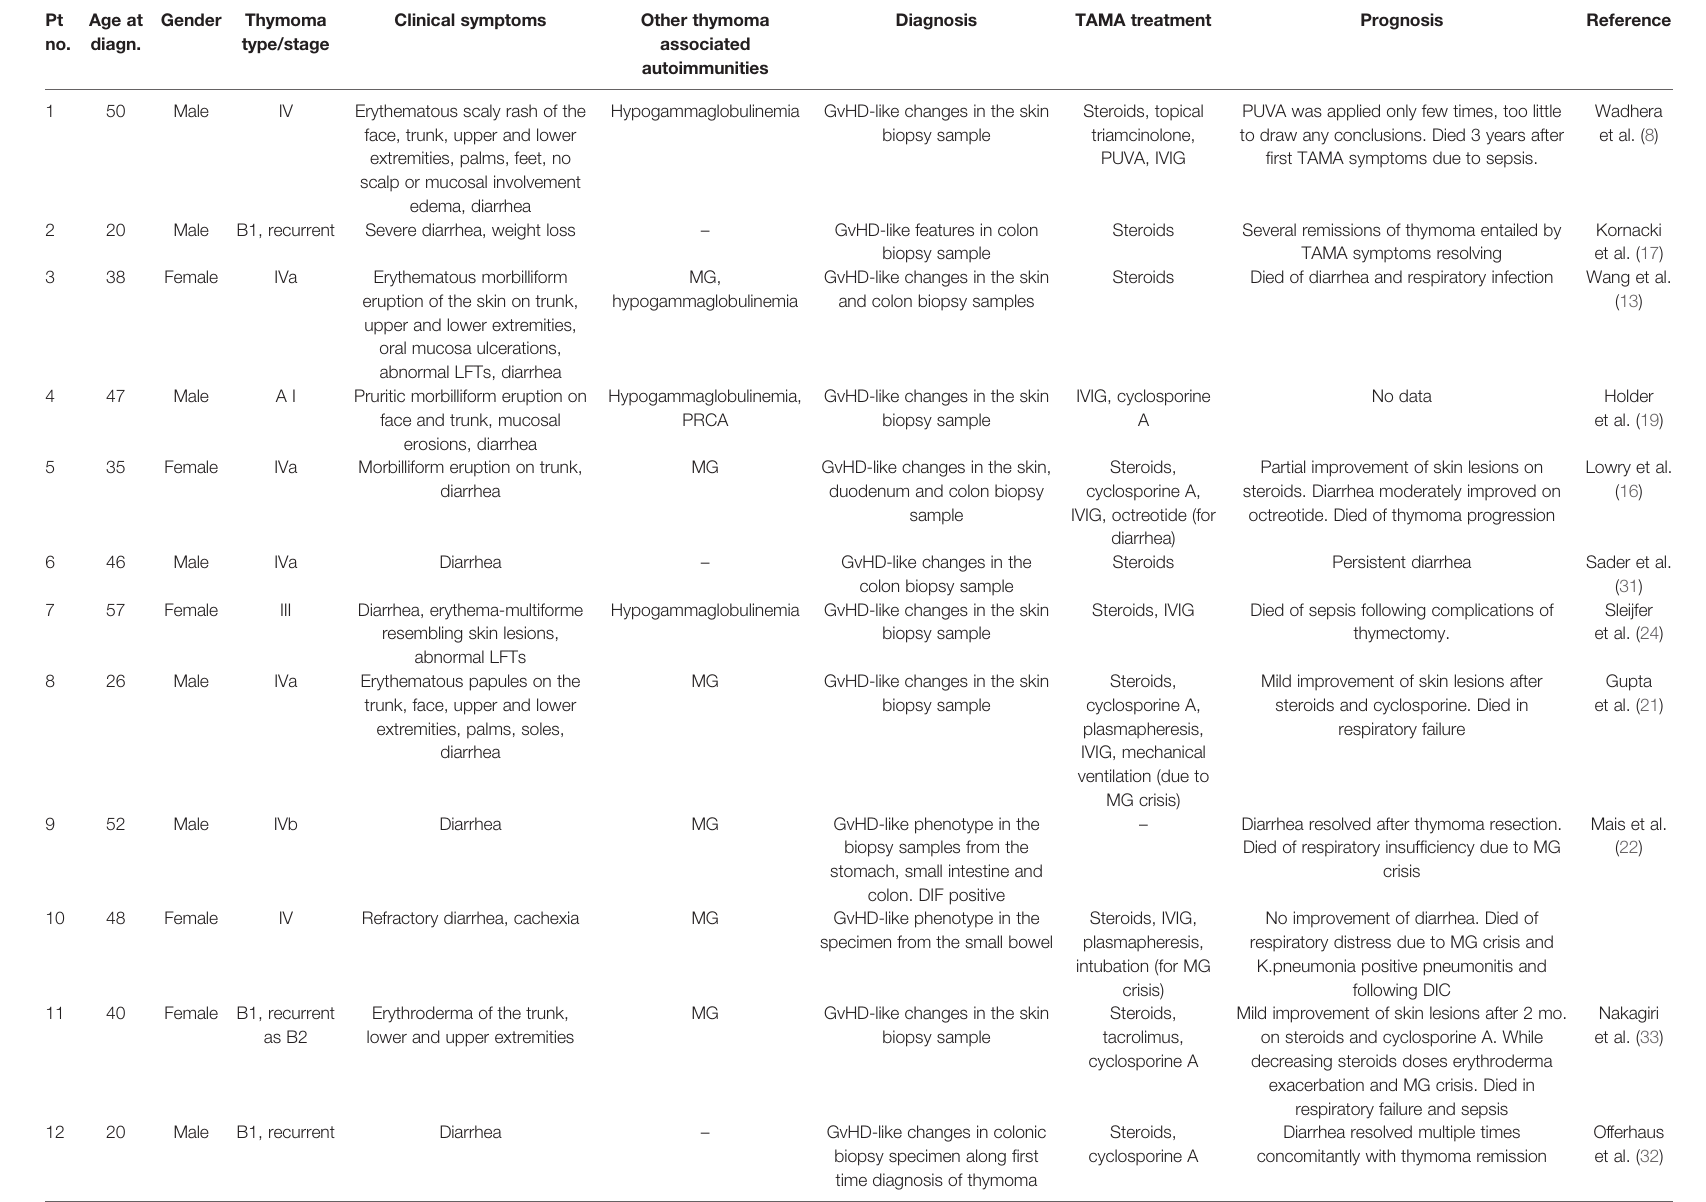
TABLE 1 | A summary of all known published cases described as Thymoma-associated multiorgan autoimmunity. Pt Age at Gender Thymoma no. diagn.